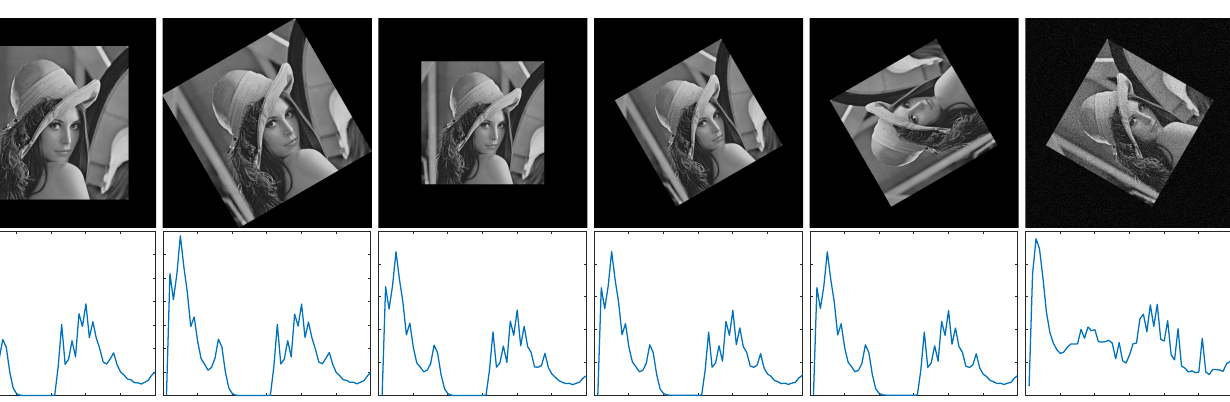
Figure 4. The PCNN-based features. The first row shows the template images, and the second row shows the PCNN-based features corresponding to the first row. (The rotation angle of each image from left to right is 0 ◦ , 30 ◦ , 0 ◦ , 30 ◦ , 120 ◦ , and 60 ◦ , respectively. The scale of each image from left to right is 1, 1, 0.8, 0.8, 0.8, and 0.8, respectively. The white Gaussian noise with a given standard deviation σ = 25 was added to the last